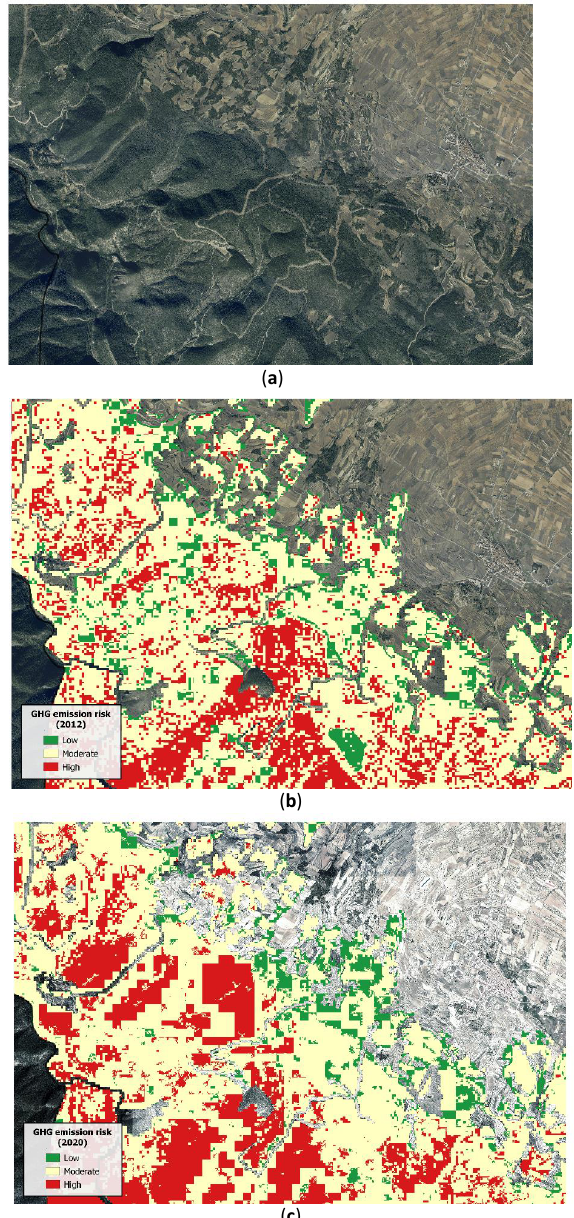
Figure 9. ( a ) Scale-up of Aras de los Olmos (orthophoto 2010). ( b ) GHG emission risk in 2012. ( c ) GHG emission risk in 2020. ( c ) GHG emission risk in